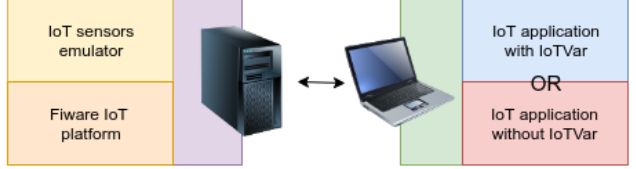
Figure 4. Computational infrastructure used in the experimental